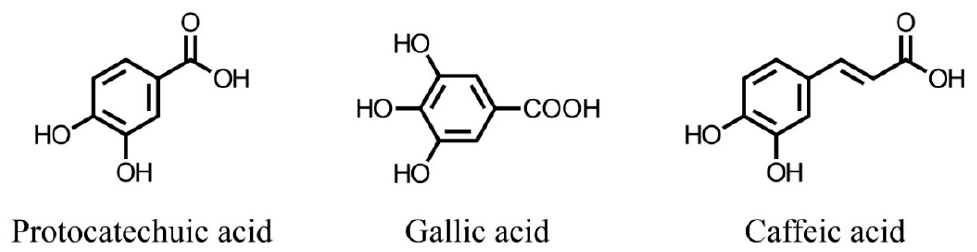
Figure 1. Chemical structures of major phenolic acids identified in peanut skin [12,17] and grape by-products [16,30].